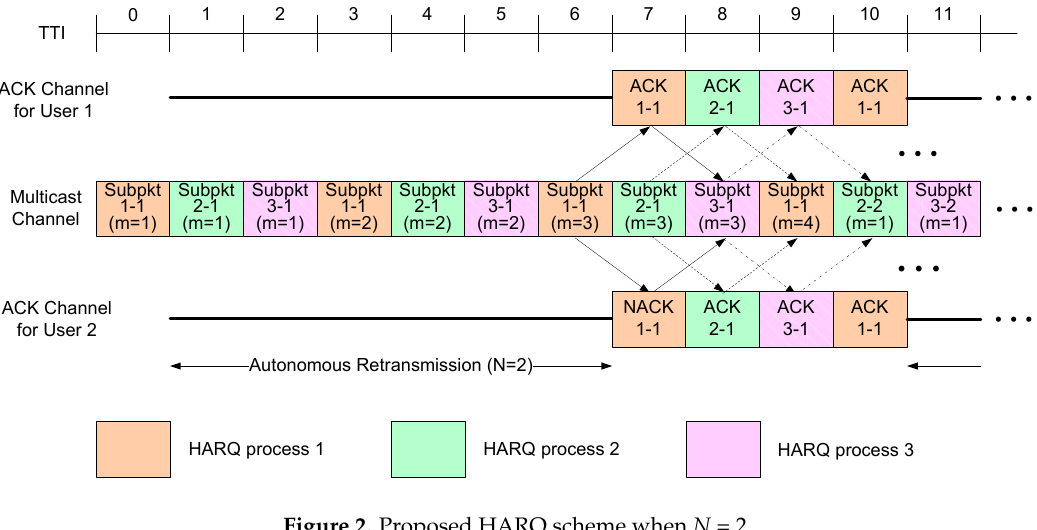
Figure 2. Proposed HARQ scheme when N = 2.